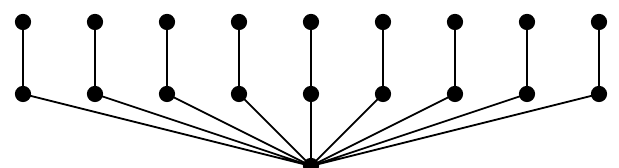
Figure 2. A subdivision of a graph S 9 gives a graph on 19 vertices where Algorithm 2 cannot provide an optimal set which maximizes 9-degree